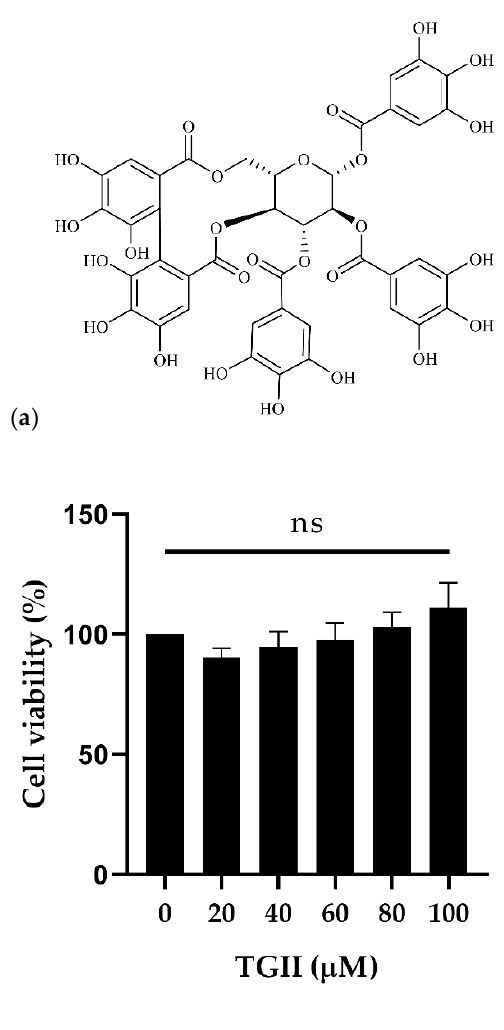
Figure 1. Effects of Tellimagrandin II (TGII) on cell viability in peripheral blood mononuclear cells (PBMCs). ( a ) Chemical structure of Tellimagrandin II; ( b ) PBMCs were treated with TGII at a dose ranging from 0 to 100 μM for 24 h, and the viability of the treated cells was determined using the WST-1 assay (quantitative data were measured at least three times and are presented as mean ± SD). Table 1. Minimal inhibitory concentration (MIC) values of methicillin-sensitive S. aureus (MSSA) and methicillin-resistant S. aureus (MRSA) after treatment with Tellimagrandin II and